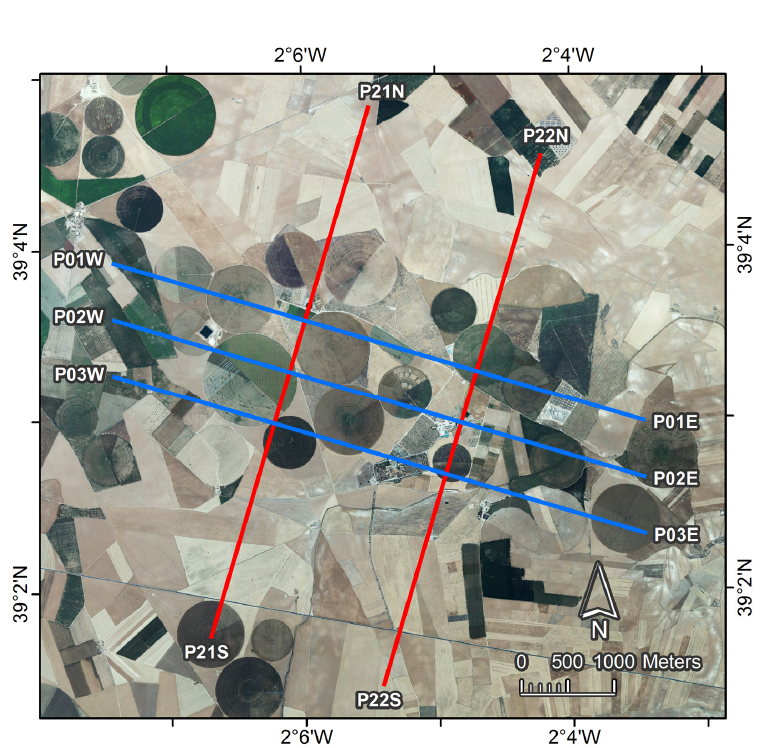
Figure 2. Flight lines over the study area on 25 July 2012. Flights marked in blue are parallel to the solar principal plane; those in red are perpendicular to the solar principal plane.